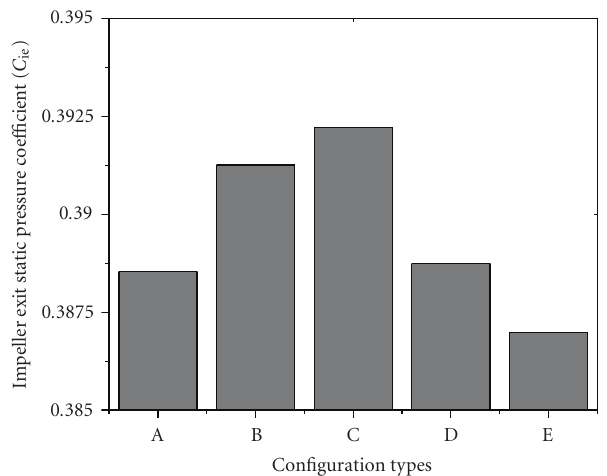
Figure 14: Impeller exit static pressure coe ffi cient for the various configurations.